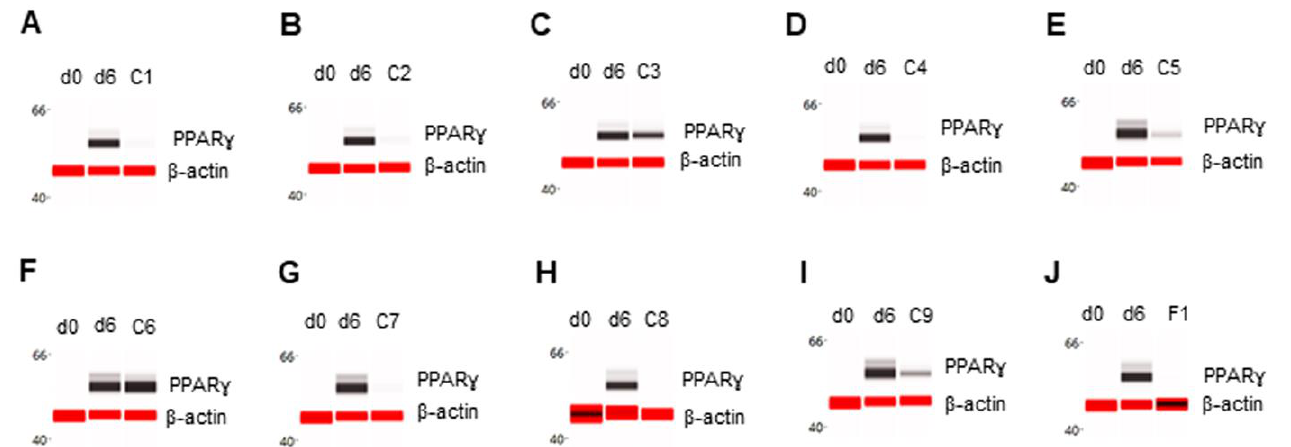
Figure 1. Suppression of PPAR γ expression in differentiating preadipocytes. Expression level of PPAR γ in preadipocytes on d0, d6 post-differentiation (d6), and d6 post-differentiation in the presence of ( A ) berberine (C1), ( B ) luteolin (C2), ( C ) resveratrol (C3), ( D ) fisetin (C4), ( E ) quercetin (C5), ( F ) fucoidan (C6), ( G ) EGCG (C7), ( H ) hesperidin (C8), ( I ) curcumin (C9), or ( J ) F1 composition. β -actin served as a loading control. The protein expression level was measured using multiplexed capillary Western immunoassays. Molecular markers in kilodalton (kDa) are displayed on the left of the capillary Western immunoassay